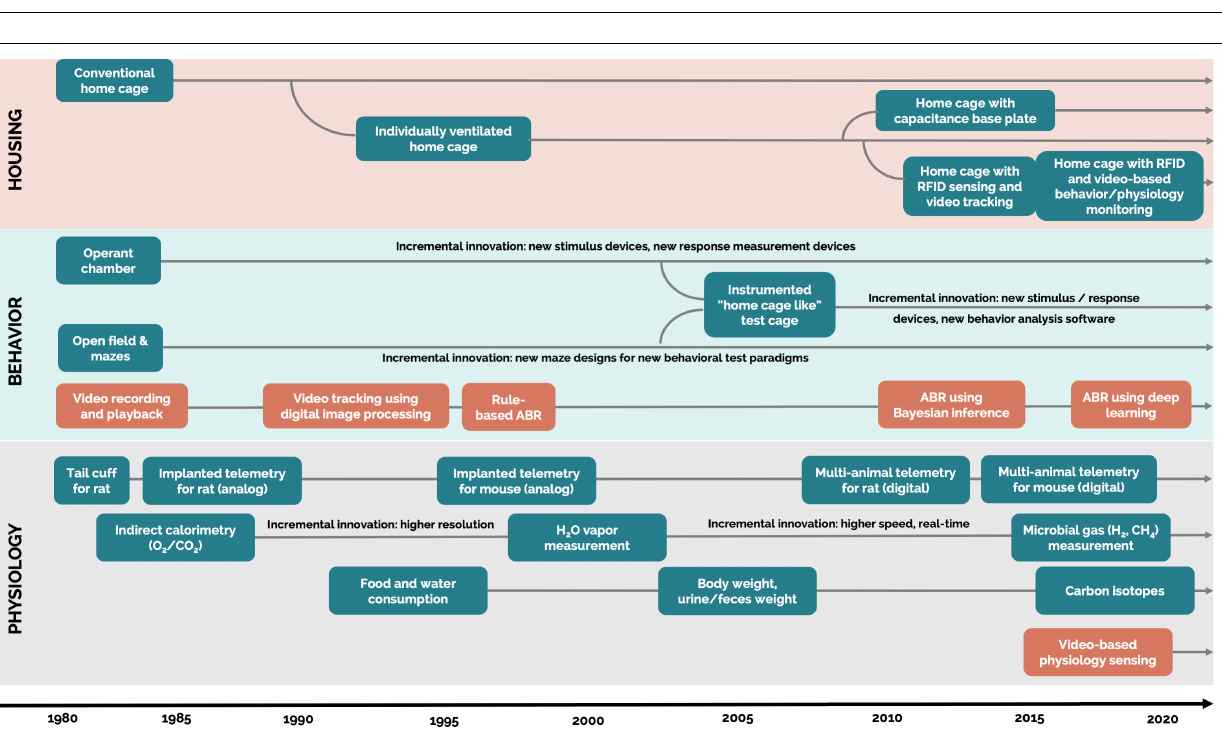
FIGURE 1 | Evolution of technologies generating digital biomarkers of rodent behavior and physiology. Each arrow extending over 2020 is a technology that is currently available. Blue rectangles: hardware. Orange rectangles: software. ABR, automatic behavior recognition. Housing: systems that are designed for permanent housing of rodents in the vivarium. Home cage: cages where the animals are housed majority of their lifetime in the vivarium. Bench top cage or technology: cages and technology (experimental test environments) not designed for permanent housing but where the animals are housed for a short (from hours up to few days) period of